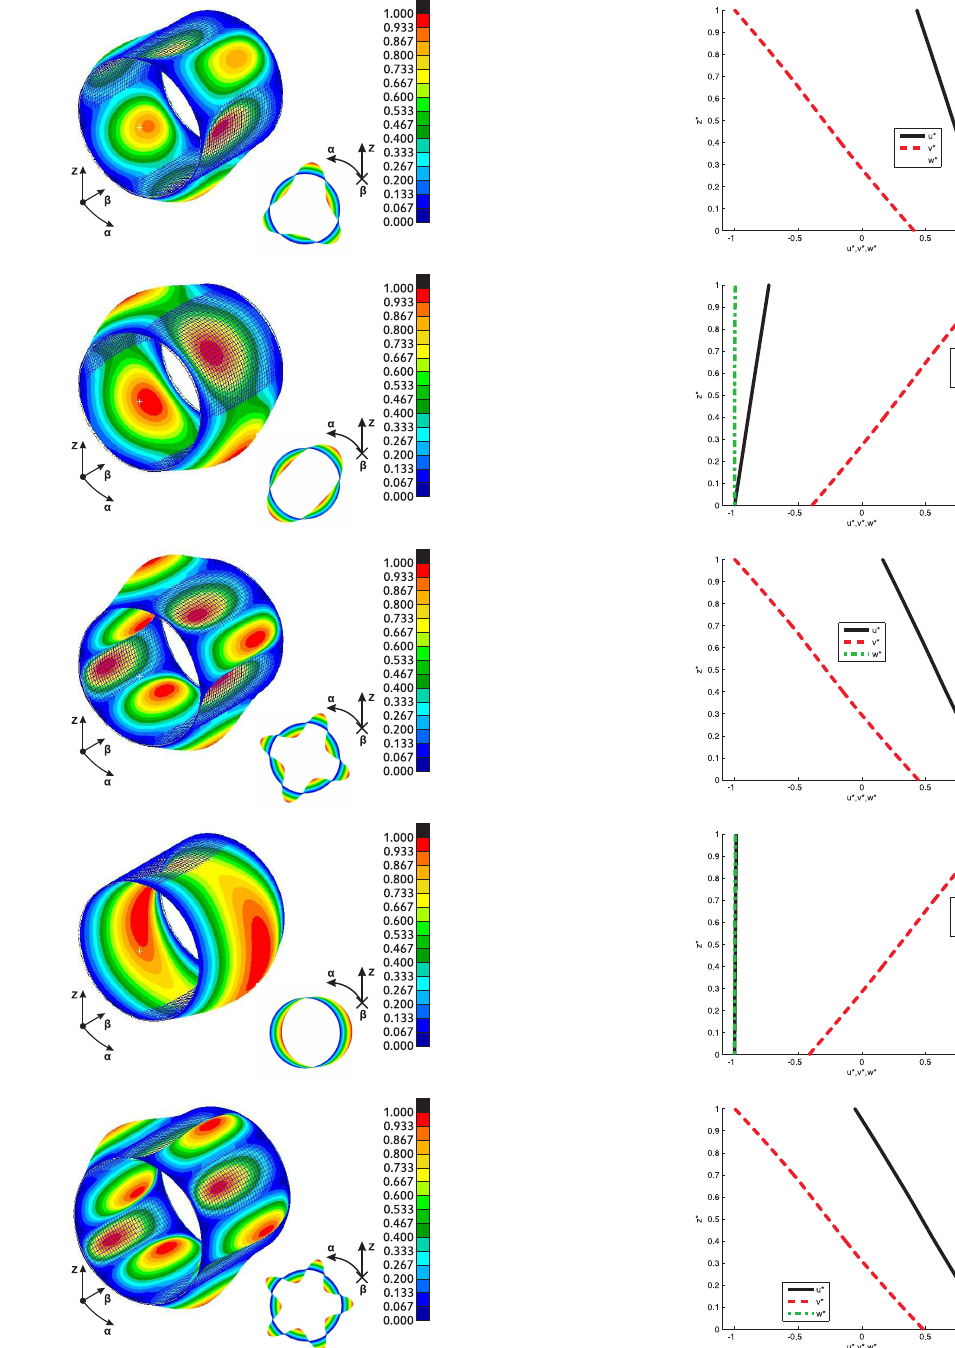
Figure 13: Eight benchmark, simply supported composite cylinder 90 ∘ /0 ∘ /90 ∘ with thickness ratio R α /h=10. First five frequencies (with transverse displacement w ≠ 0) via 2D FE solution (on the left) and via 3D exact solution (on the right).